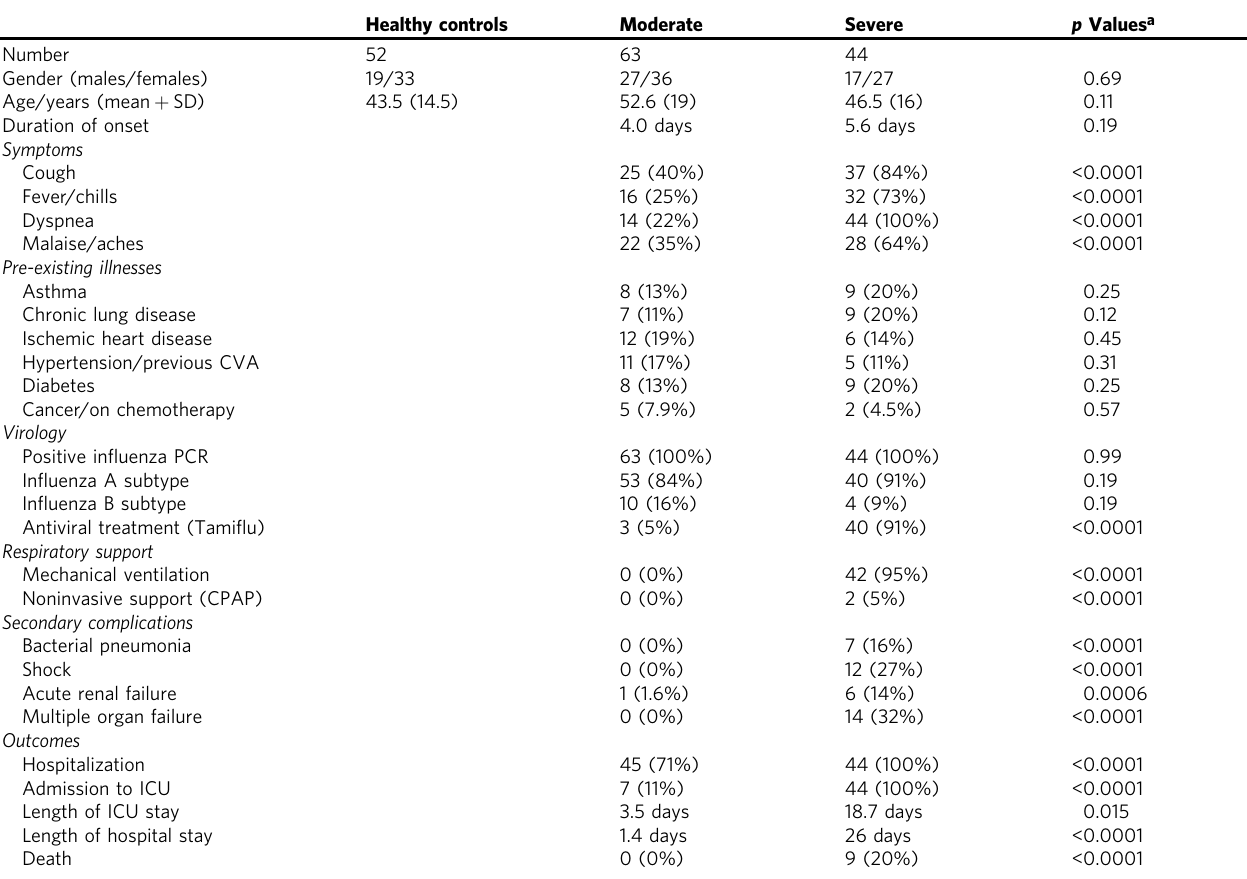
Table 1 Demographic and clinical characteristics of the study groups Healthy controls